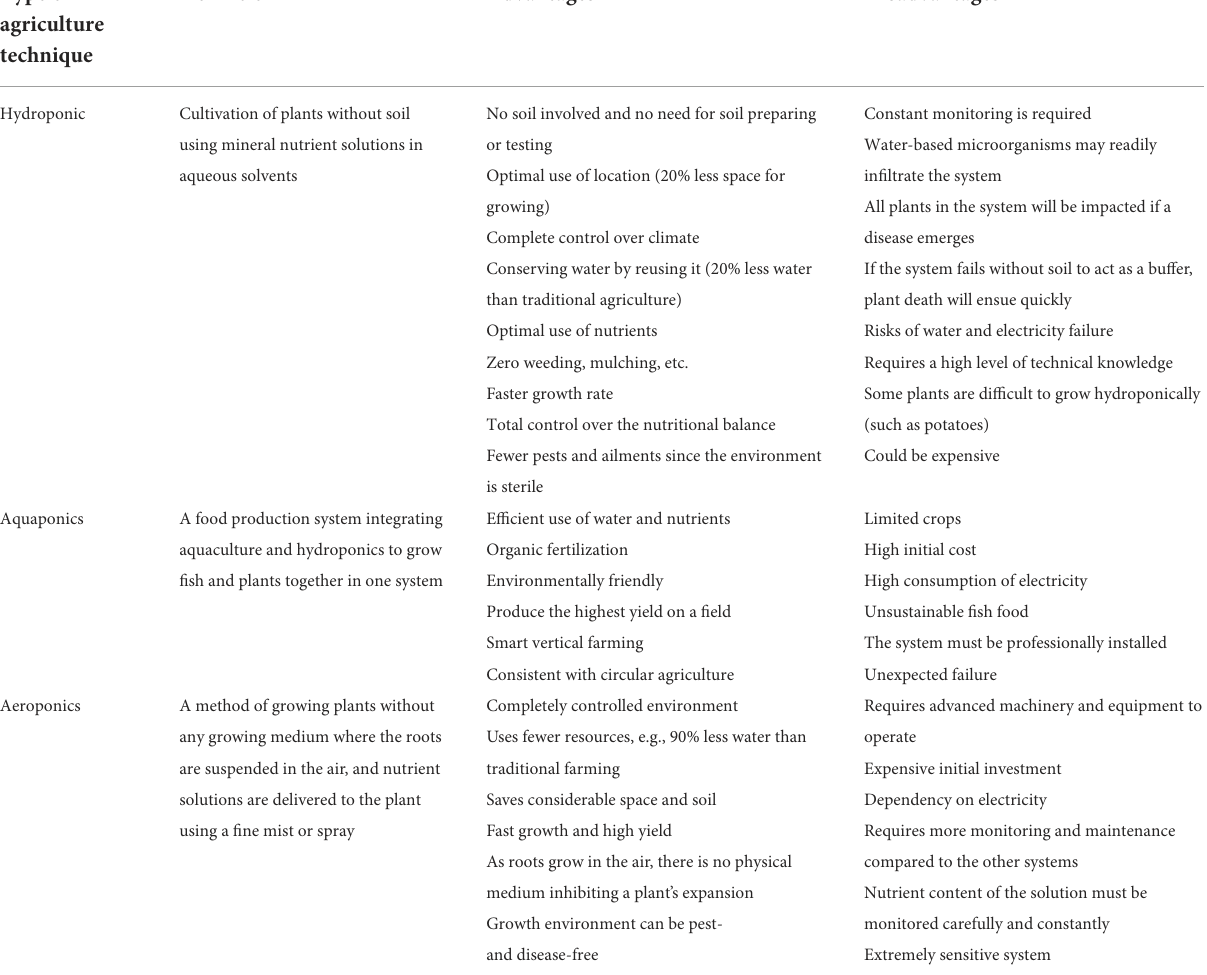
TABLE 2 New food production